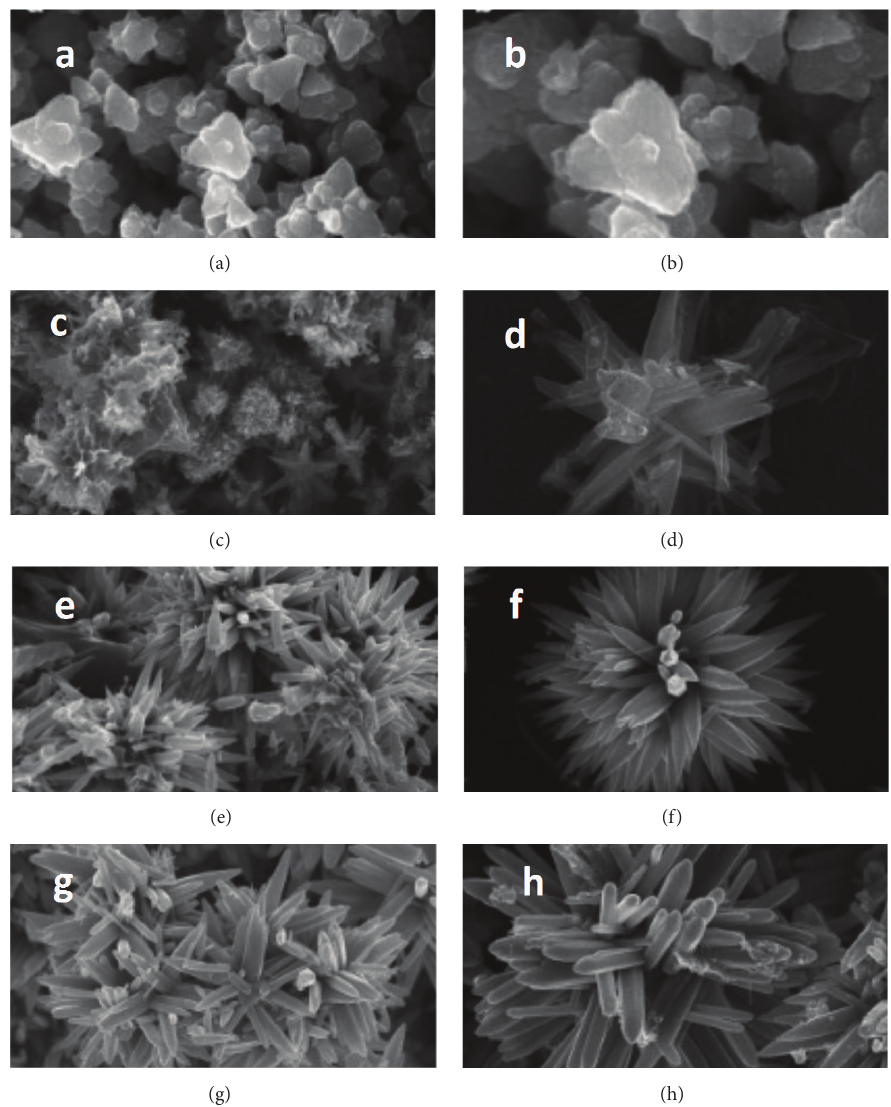
Figure 5: Low and high resolution FESEM images of (a and b) stirred sample and samples synthesized/refluxed at (c and d) 40 ∘ C, (e and f) 60 ∘ C, (g) at 80 ∘ C, and (h) at 100 ∘ C for 20 min each [62].